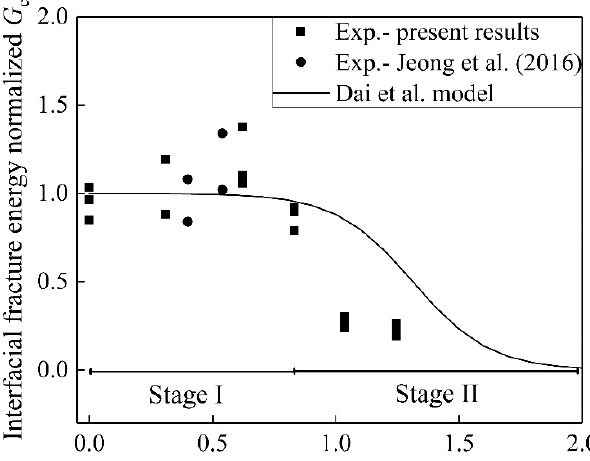
Figure 13. E ff ects of the pre-sustained load on the FRP-to-concrete